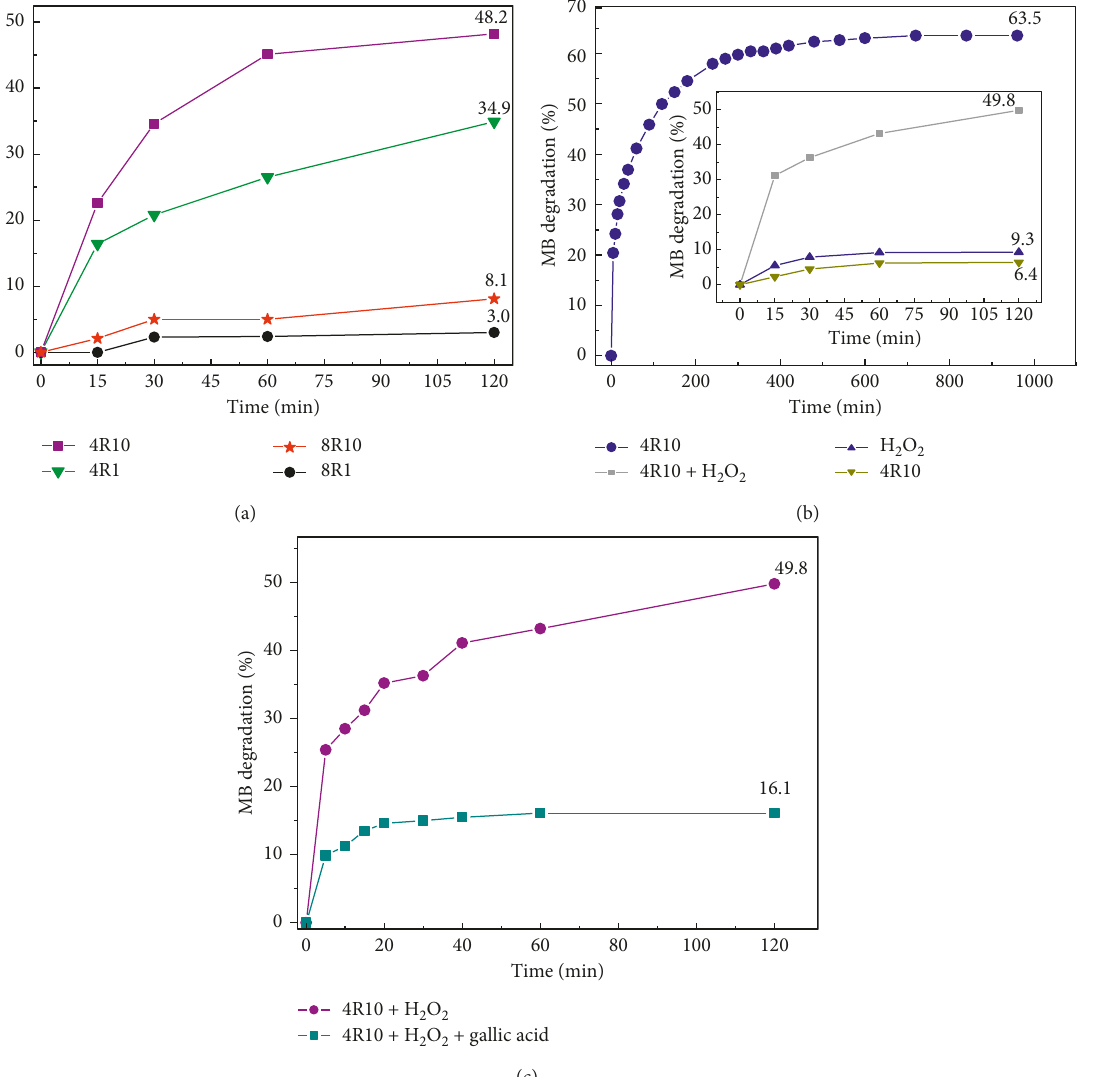
Figure 5: MB degradation. (a) Reactions using H 2 O 2 as an oxidizing agent. (b) 4R10 material using H 2 O 2 as an oxidizing agent. Insert: comparison with the reaction blanks up to 120min. (c) Effect of the gallic acid addition on the MB degradation for the 4R10